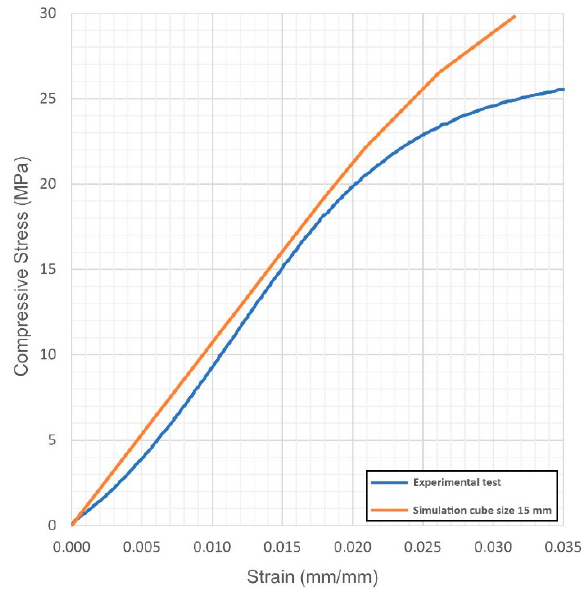
Figure 9. Condition 6, stress-strain diagram; comparisons between simulated and actual specimens. Table 5. Mechanical properties for each condition and percentage mismatch to the experimental values. Cond. Real Specimen Cond.